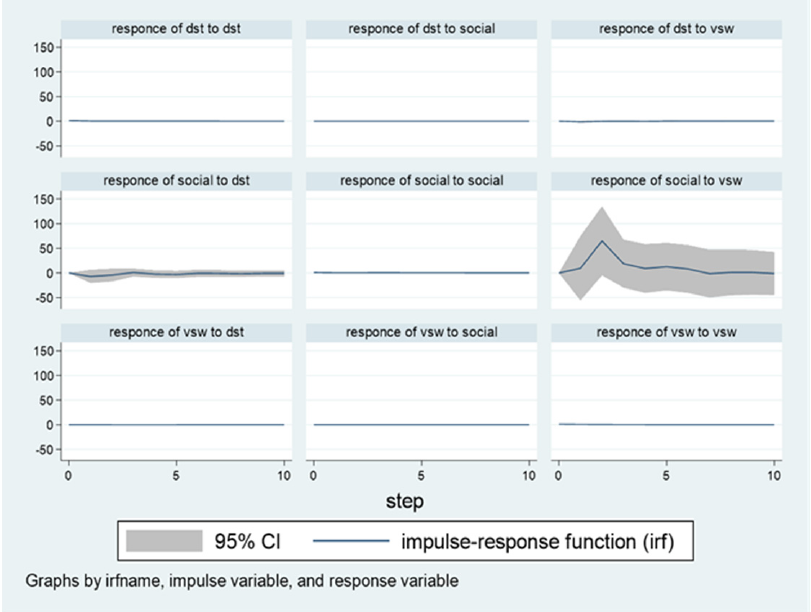
Figure 2. Response of electricity consumption of the whole of society to space weather.